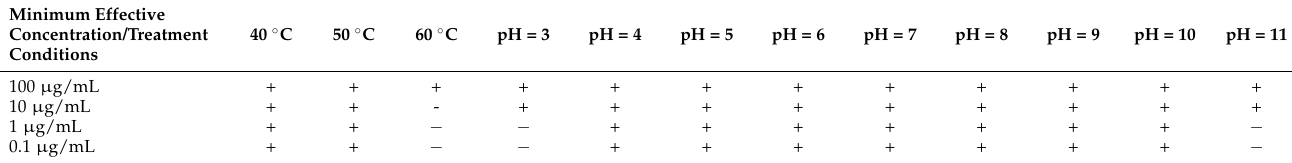
Table 2. The temperature and pH stability of depolymerase